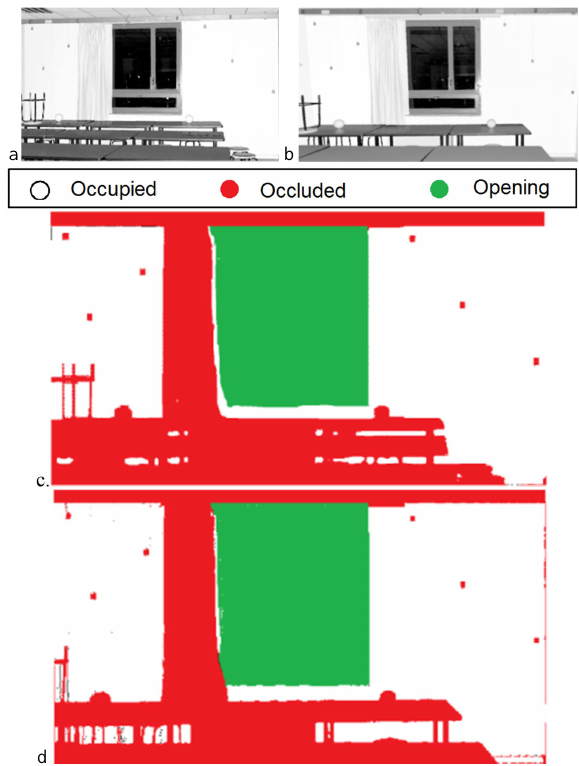
Figure 7. Occlusion labelling (‘Classroom’ data set). Reflectance images of Scan 1 (a) and Scan 2 (b) used to model the wall; cell labelling for Scan 1 (c) and Scan 2